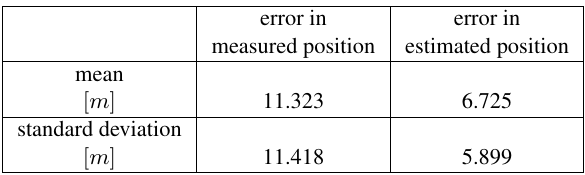
Table 2. The measured GPS position error using